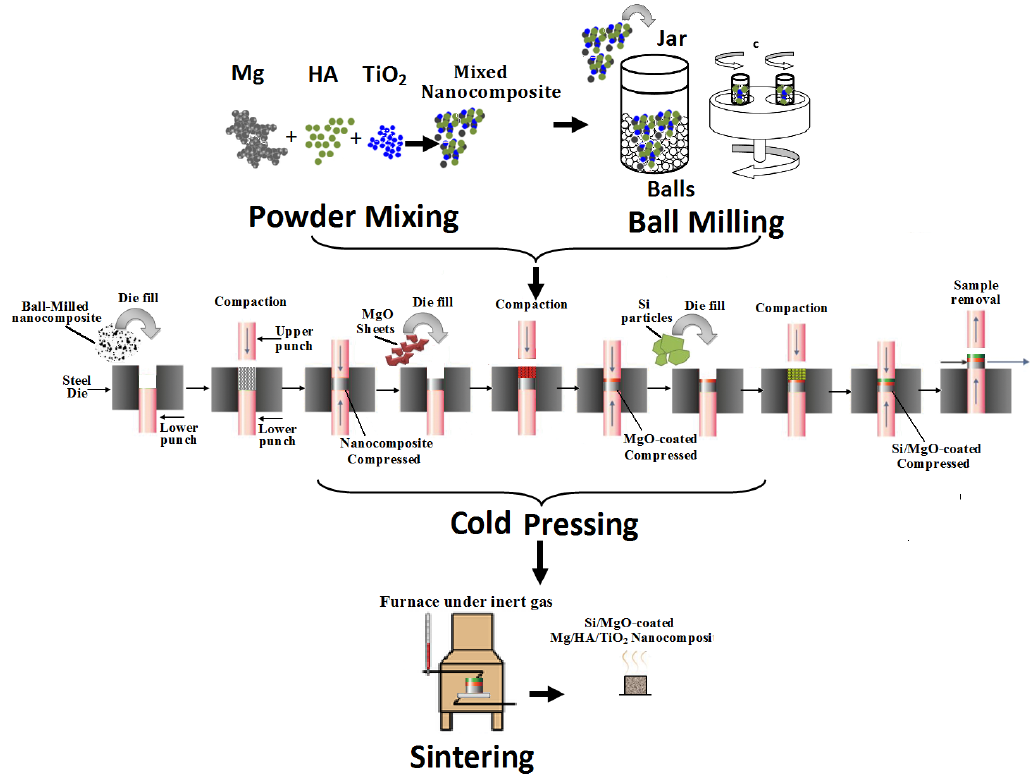
Figure 1. A schematic image of the ball milling ‐ multi step cold pressing ‐ sintering powder metallurgy process to fabricate MgO ‐ coated and Si/MgO ‐ coated Mg/12.5HA/10TiO 2 Bionanocomposite.